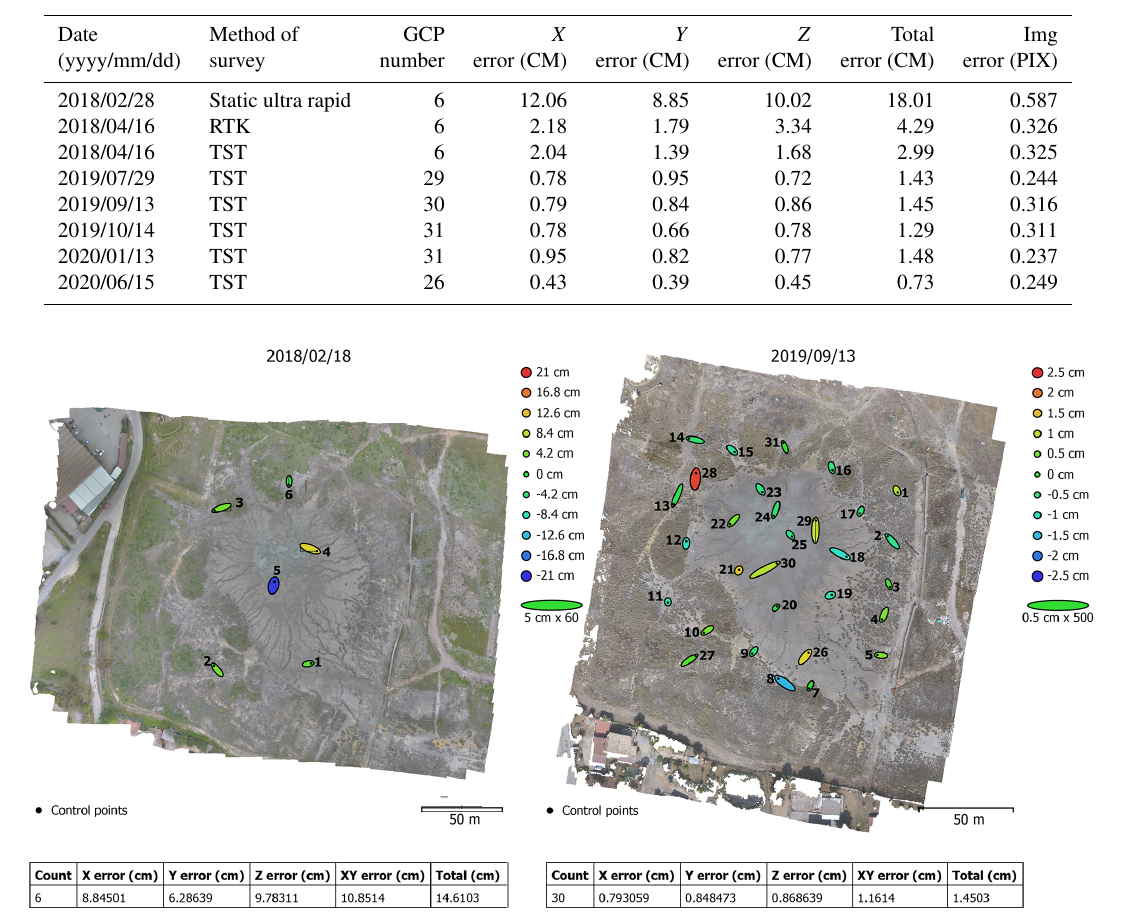
Figure 4. GCPs locations and error estimates. Z error is represented by the color of the ellipse. X and Y errors are represented by ellipse shape. GCP locations are marked with a dot. Note that the different scale of the error ellipse in green: in the left image the ellipse in X direction is enlarged 60 times, and in the right image it is enlarged 500 times. The reference system is WGS 84/UTM zone